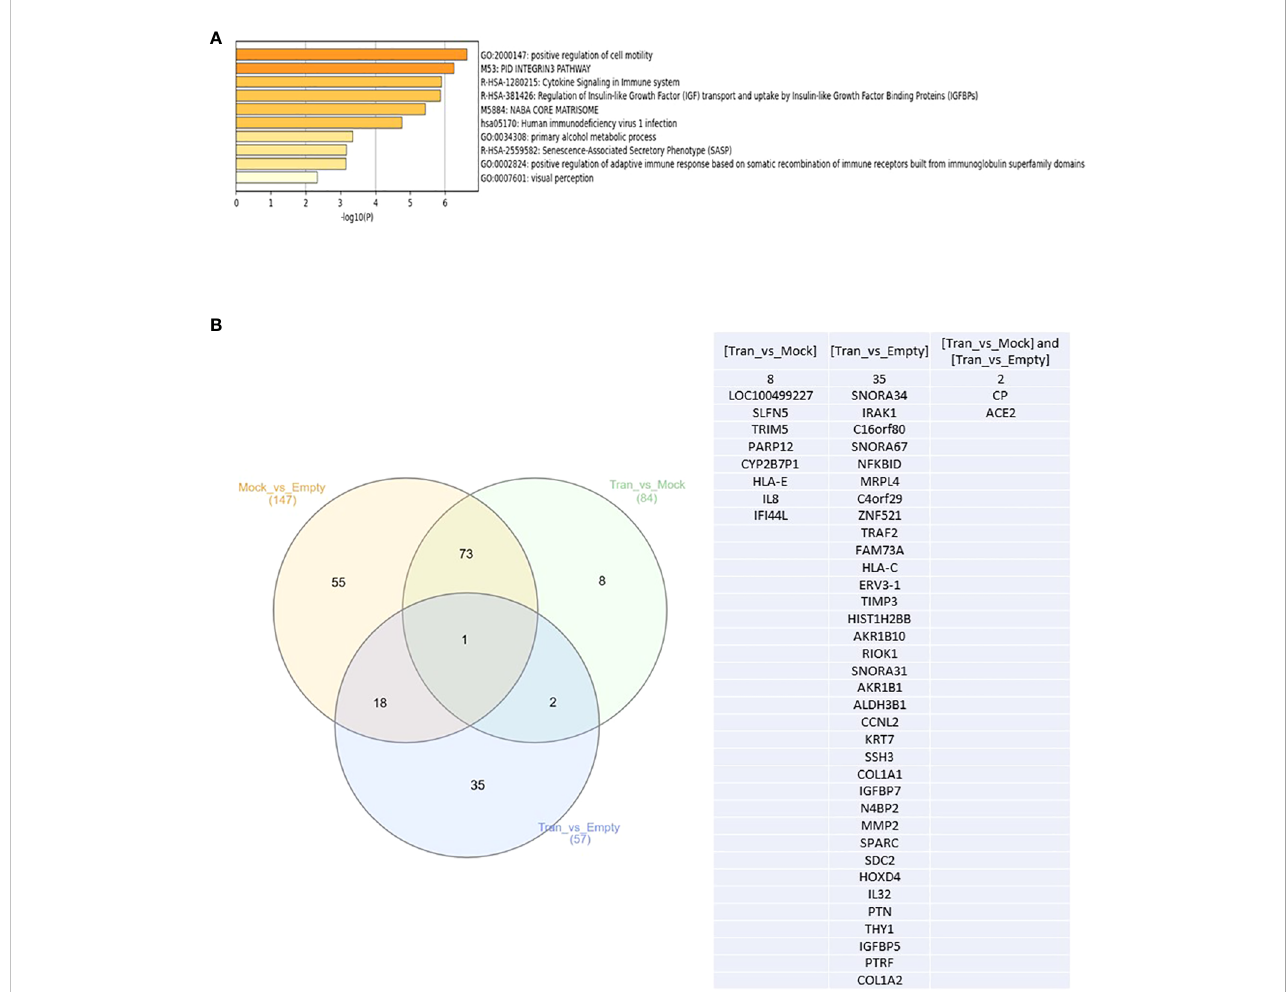
FIGURE 3 (A) Top enriched pathways in DKK3 transfected PC3 cell lines compared to empty vector and Mock cells obtained from our RNA seq analysis. (B) Intersecting the differential expressed genes between DKK3 transfected PC3 cell lines , empty vector and Mock cells obtained from our RNA seq